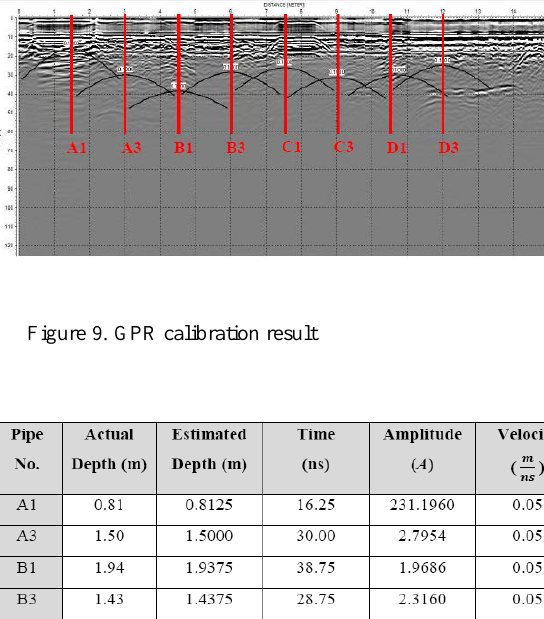
Figure 11 . Image of water